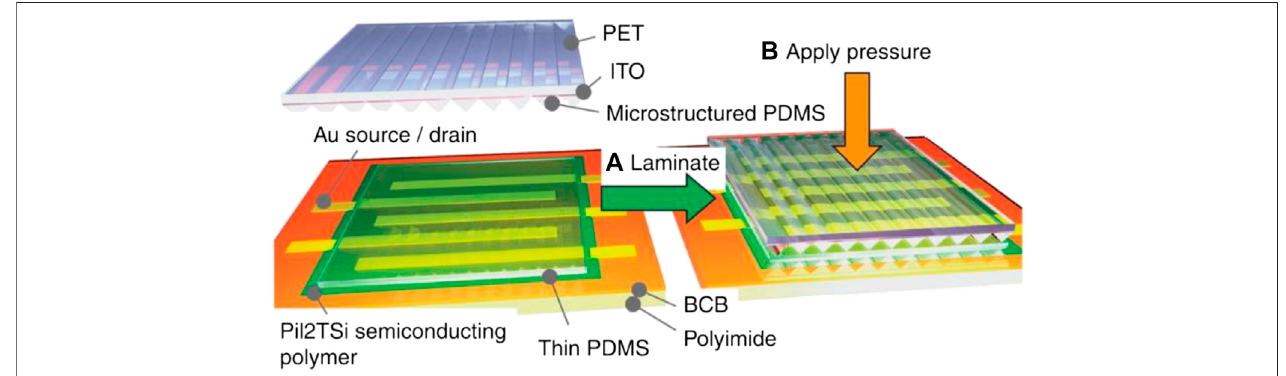
FIGURE 2 | Schematic diagram of sensor structure. It is made by laminating two layers. The fi rst contains the bottom source-drain electrodes and the semiconducting polymer, and the second contains the gate electrode and the microstructured dielectric. The thin PDMS layer on top of the semiconductor ensures a homogeneous dielectric interface and provides protection during the lamination step (Schwartz et al., 2013). Reproduced with permission.